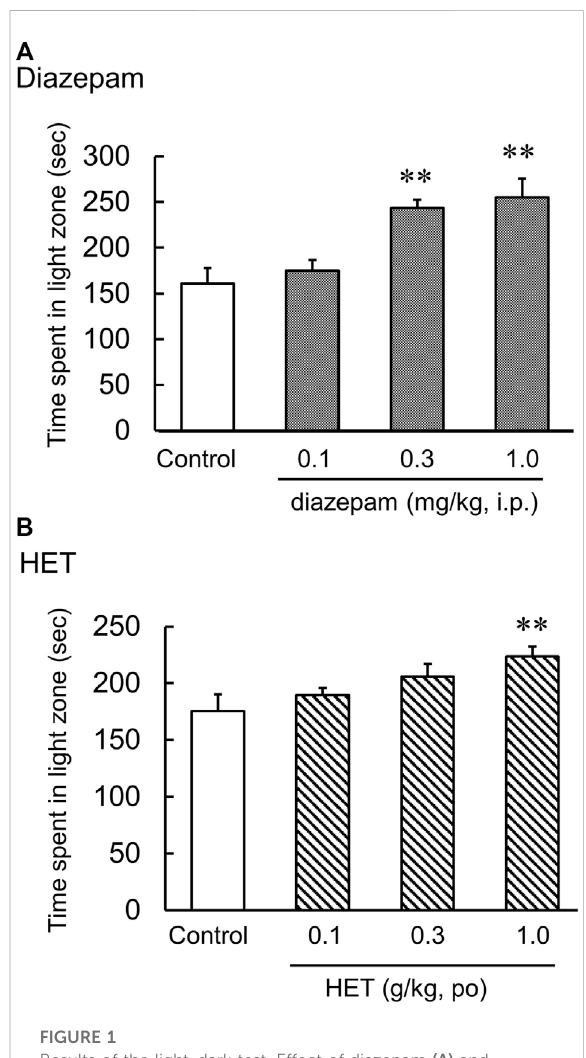
FIGURE 1 Results of the light-dark test. Effect of diazepam (A) and hochuekkito (HET) (B) on the time spent in the light zone, that is, showing anxiolytic-like behavior in control mice, mice single administered diazepam and mice administered HET for 2 weeks. Data are shown as mean ± standard error of mean (SEM); n = 6 – 8 per group. **: p < 0.01 (vs.